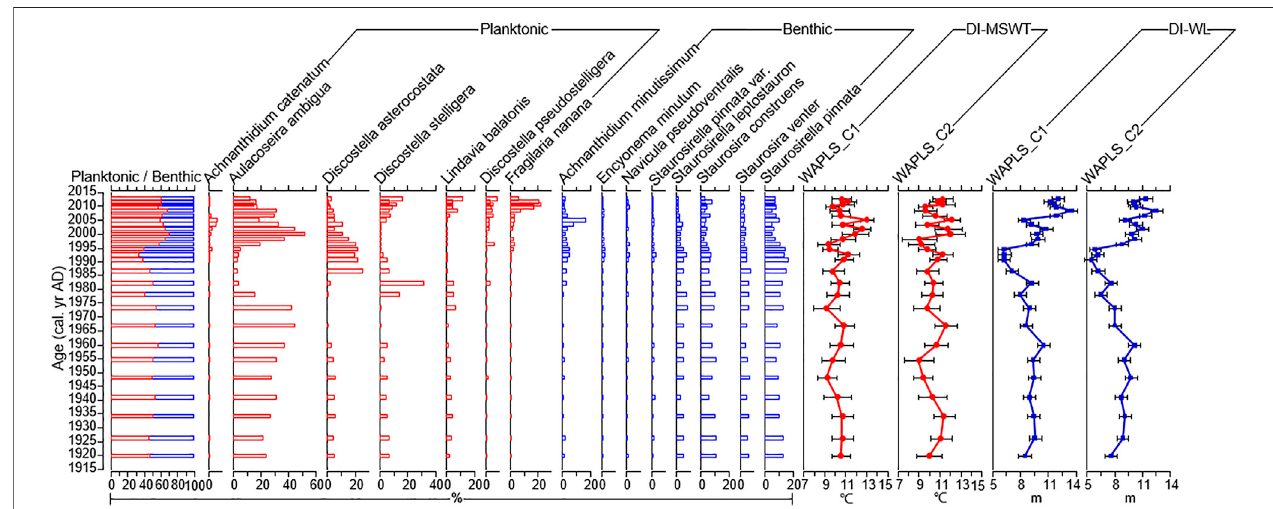
Frontiers in Earth Science |